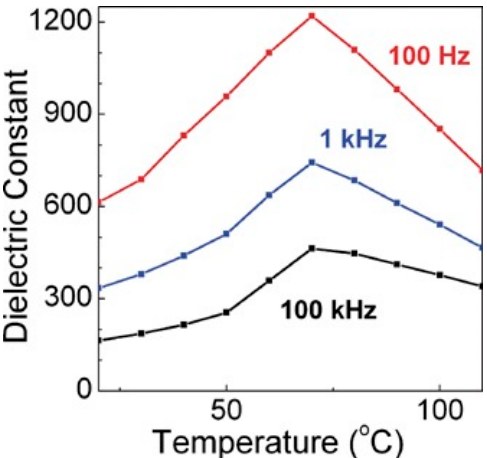
Figure 5. Permittivity at 100 Hz, 1 kHz and 100 kHz vs. temperature for hot-pressed composites. Reprinted with permission from [16]. Copyright 2007 WILEY-VCH Verlag GmbH & Co.